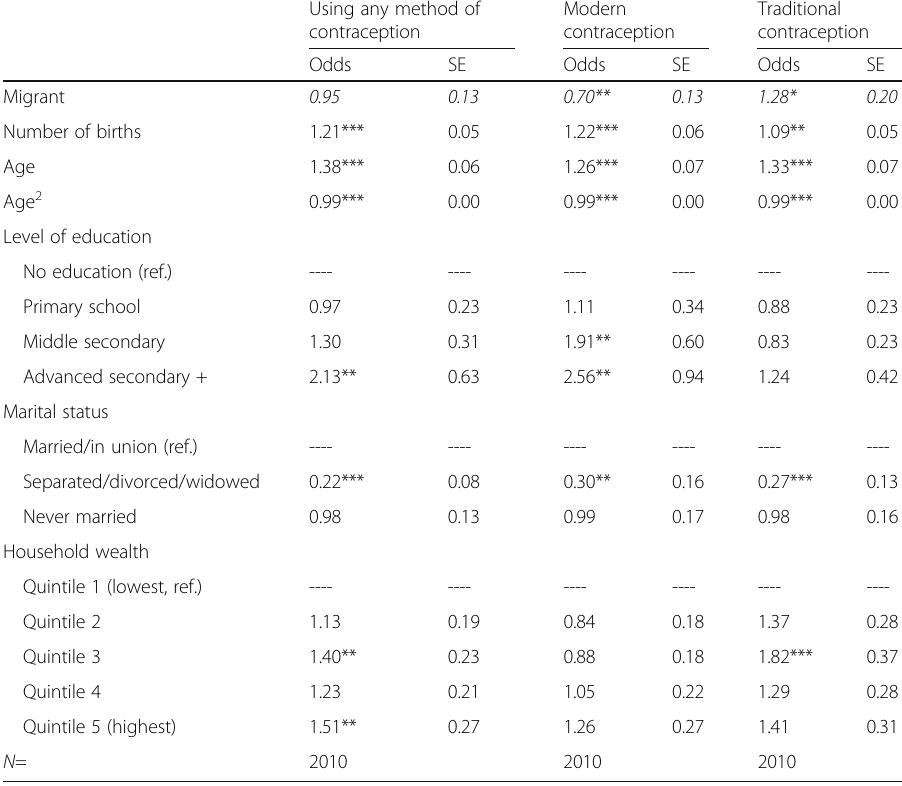
Table 4 Logistic regression results for differences in current contraceptive use between migrants and non-migrants, PMA2020 Project, Kinshasa 2013